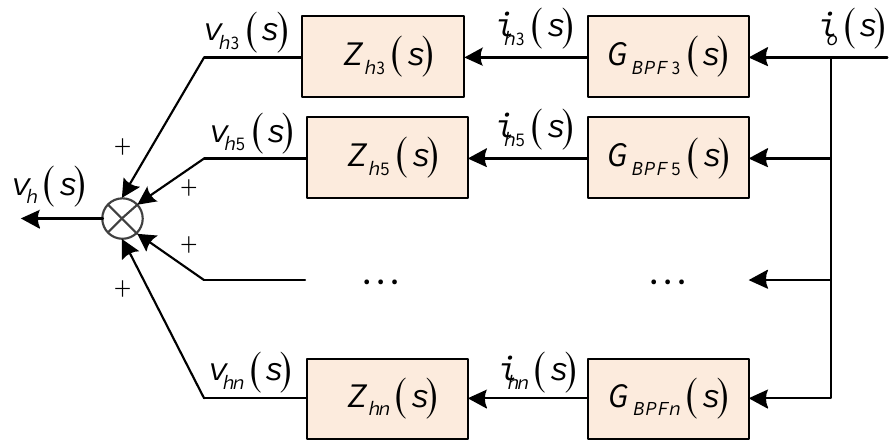
Figure 6. The transfer function of the harmonic compensation